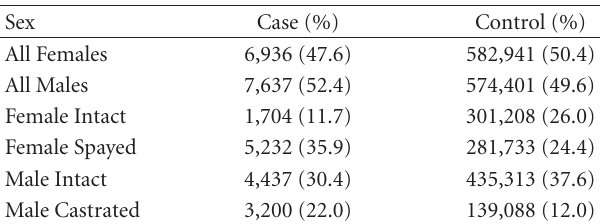
Table 1: Sex distribution of lymphoma dogs evaluated in the VMDB (1964–2002).